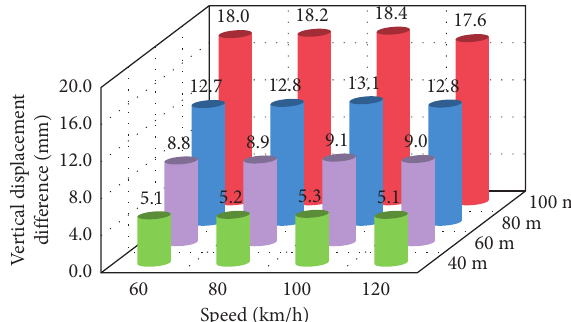
Figure 20: The variation trend of the vertical displacement difference.